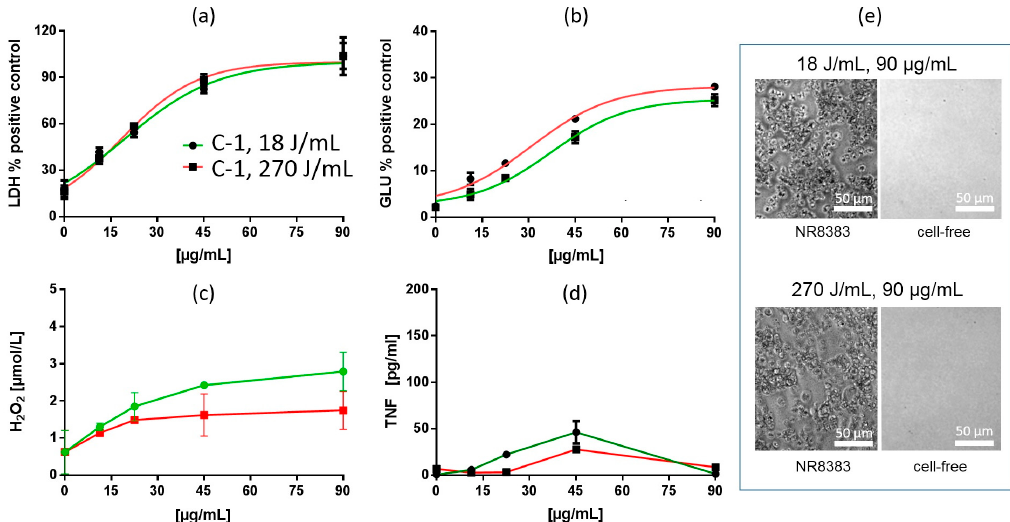
Figure 10. In vitro response of NR8383 alveolar macrophages to colloidal silica C-1. Particles were dispersed with either 18 J/mL (green) or 270 J/mL (red). ( a ) lactate dehydrogenase activity (LDH), ( b ) glucuronidase activity (GLU), ( c ) H 2 O 2 concentration, and ( d ) tumor necrosis factor alpha (TNF). ( e ) NR8383 cells after 16 h exposure to P-5, dispersed with 18 J/mL or 270 J/mL; right panels show particles settled onto the bottom of culture well under cell-free conditions. Note that cells treated with both qualities appear shrunk and deteriorated; C-1 particles are not visible on phase contrast